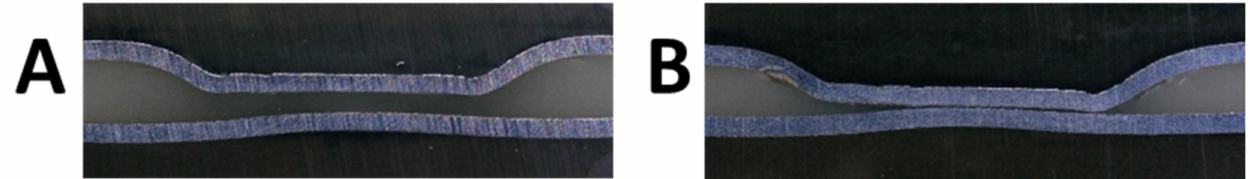
Figure 10. Selection of the induction preheating parameters: ( A ) too short time 20 s and ( B ) correct heating time 30